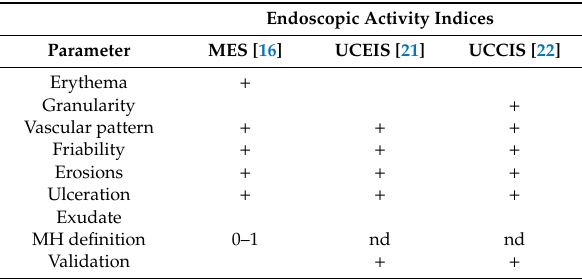
Table 1. Selected endoscopic disease activity indices for ulcerative